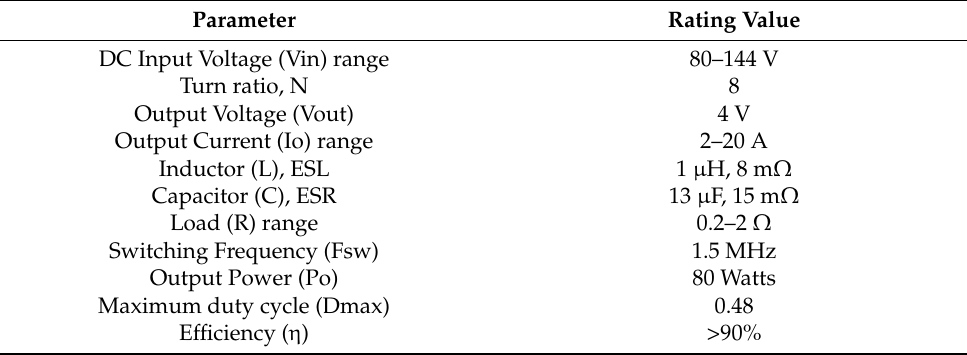
Table 1. Design parameters of the Dual-Switch Forward converter. Parameter Rating